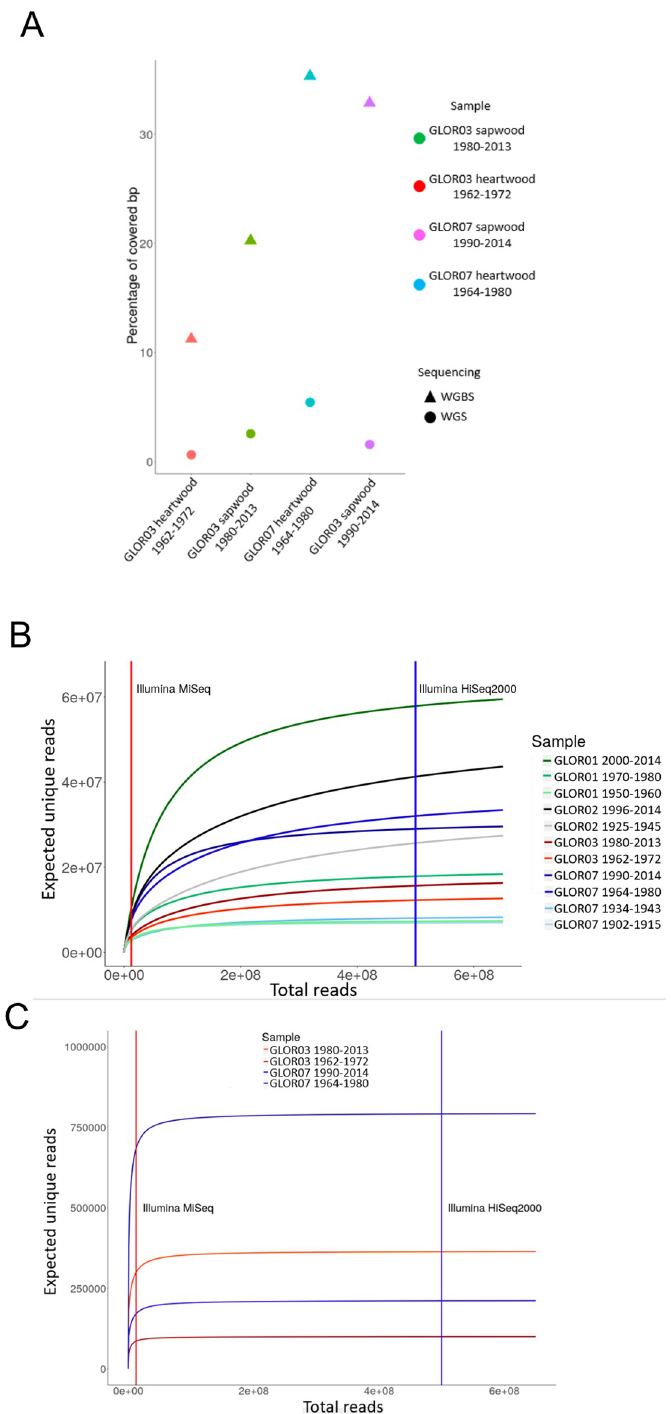
Fig 5. WGBS is not feasible in oak heartwood. A) Percentage of genomic bases covered by at least one WGS or WGBS DNA read generated from the sequencing of the GLOR07 and GLOR03 sapwood and heartwood samples. B-C) Number of distinct reads expected to be obtained at the increase of the total number of reads as predicted by Preseq [60]. We included the WGS (B) and WGBS (C) libraries having a number of endogenous reads compatible with the software requirement. We reported the number of reads generated by an Illumina MiSeq (21 hours run, chemistry version 3, 75 bp reads) and Illumina HiSeq2000 (8 days run, 100 bp reads).